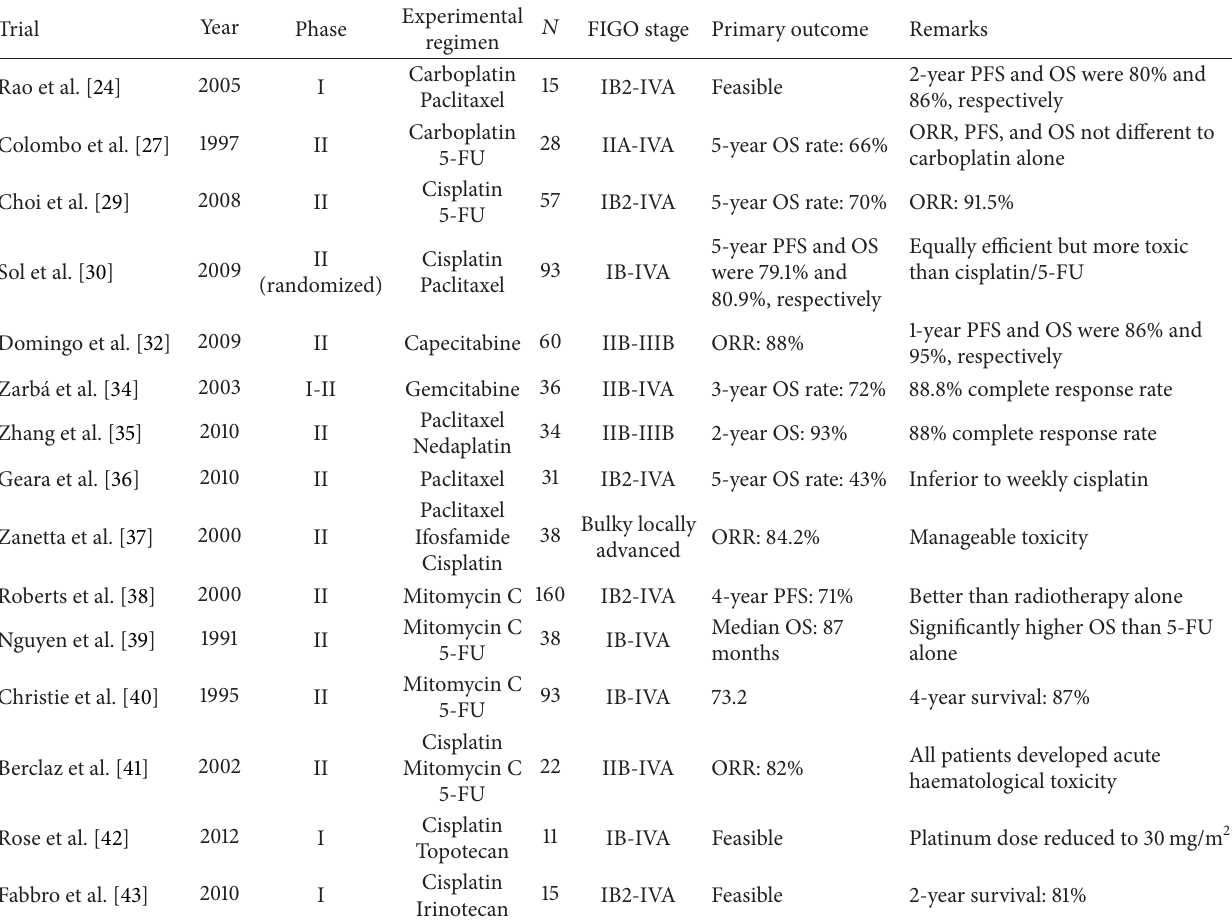
FIGO: International Federation of Gynecologic Oncology; CRT: chemoradiotherapy; OS: overall survival; PFS: progression-free survival; ORR: objective response rate; 5-FU: 5-fluorouracil; PVI: protracted venous infusion; 𝑁 : number of patients. Table 3: Main clinical trials implementing molecular targeted agents concurrently with external beam irradiation in patients with locally advanced cervical cancer. 𝑁 FIGO stage Primary outcome Remarks